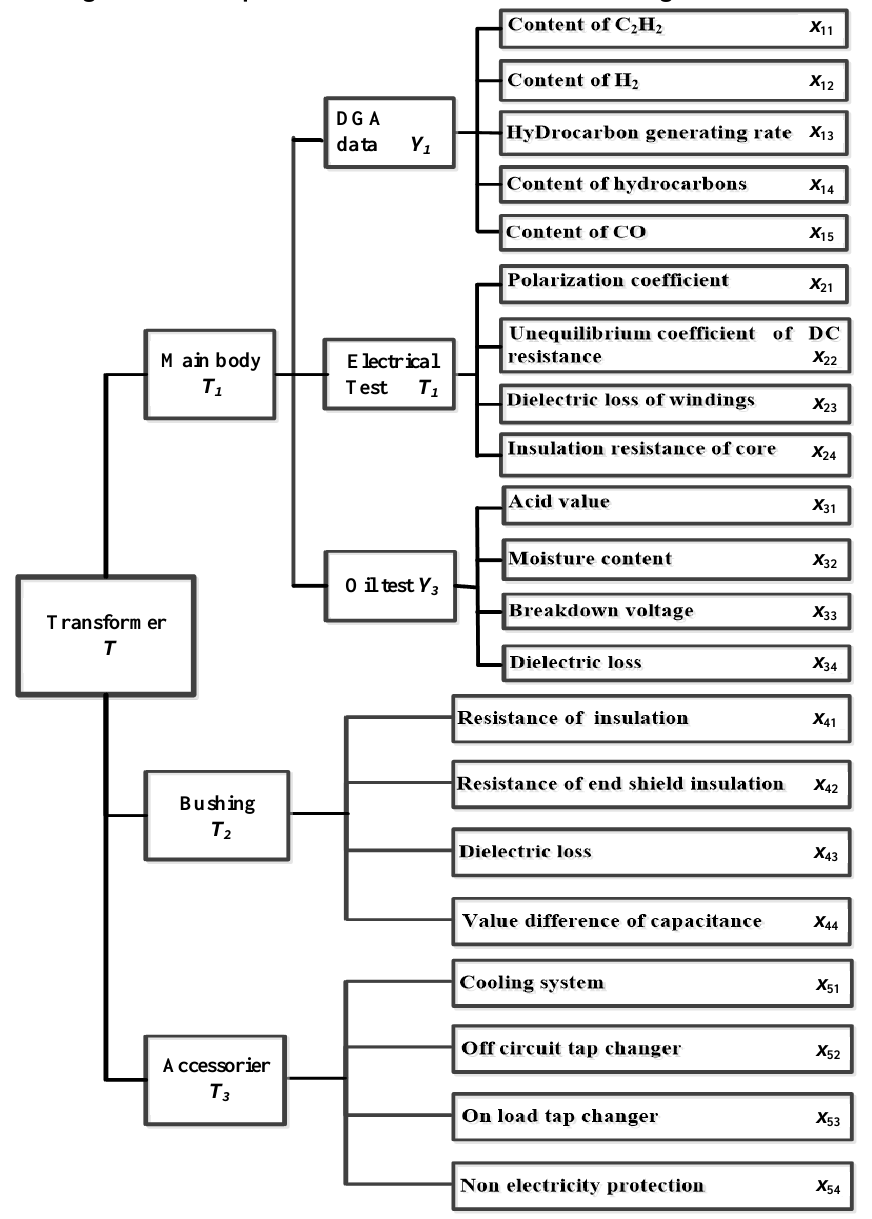
Figure 1. Synthetic assessing index system.